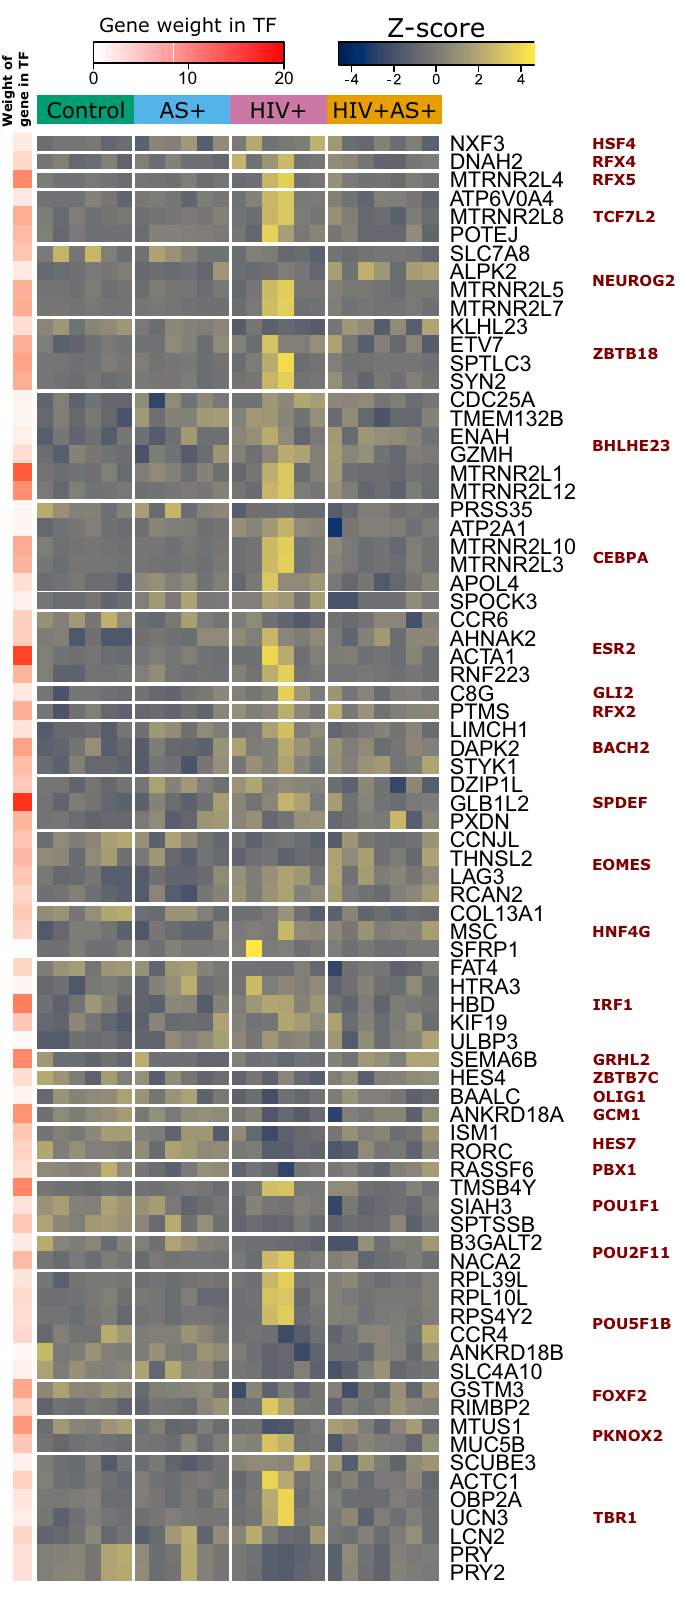
2 | > = 0.4 Figure 2. Gene targets of transcription factors correlated | r with cytokine and chemokine levels in plasma. Expression of the differentially expressed targets (p-adj < 0.1, LFC > 1.0 in any comparison) of transcription factors from Fig. 1. Expression shown as z-scores across all four groups (indicated by top bar). The weight of each gene in determining spTF score is shown on left (white to red color bar) as the percentage of the variance accounted by the gene. Analysis and graphical output done in R (ver 3.5.1) 57